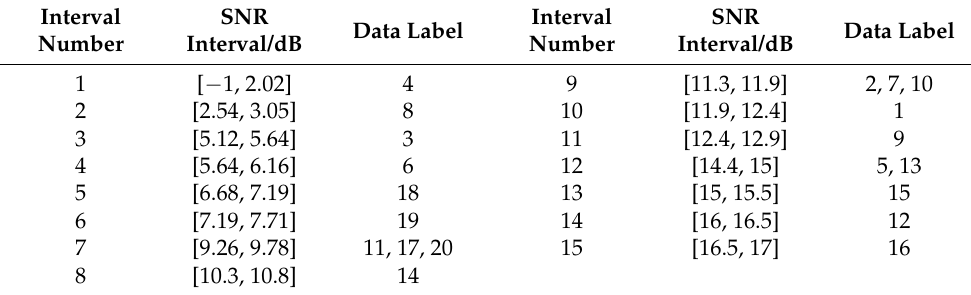
Table 2. Classification table of the average signal-to-noise ratio of IPIX radar